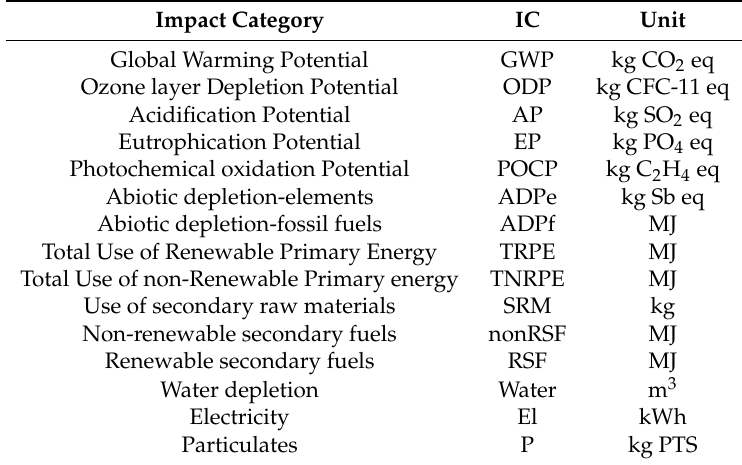
Table 1. Assessed impact categories.